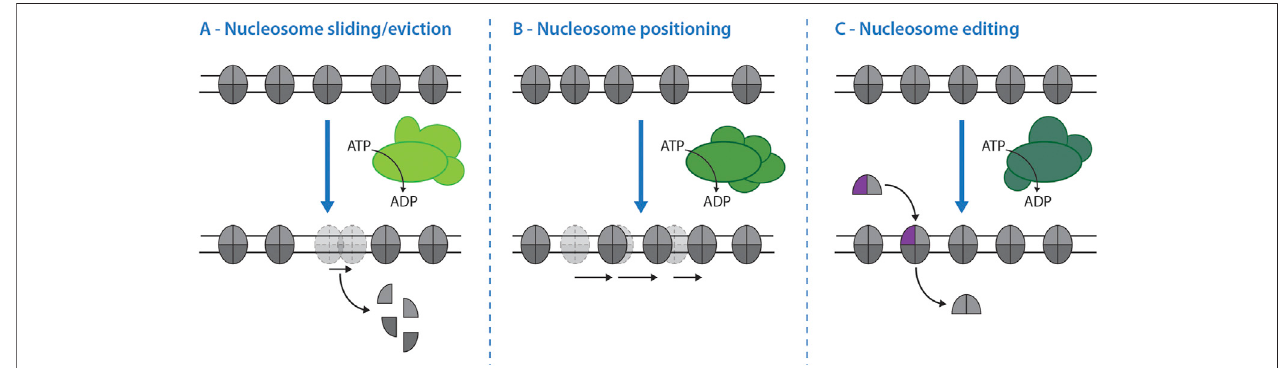
FIGURE 2 | Nucleosome remodeler activities and their effects on chromatin. The activity of different nucleosome remodelers (shades of green) can result in three principal effects on nucleosomes. (A) – Nucleosome sliding and eviction. While all remodelers have the propensity to slide nucleosomes, eviction of nucleosomes from double-stranded DNA iscatalyzed mainly by theSWI/SNFsub-family ofnucleosomeremodelers. (B) – Nucleosome positioning. Some nucleosome remodelers have the abilitytoslideandpositionnuclesomesonDNAinacontrolledfashionthatleadstotheformationofregularlyspacedarrays.Inthebuddingyeastsystemthisactivity is catalyzed mainly by ISW1a-, ISW1b-, Chd1 and INO80-complexes. (C) – Nucleosome editing. Nucleosome editing is de fi ned as the exchange of canonical histones (grey) for non-canonical histone variants, like H2A.Z (purple), within the nucleosome and vice versa. In budding yeast H2A/H2A.Z exchange is performed by the INO80 sub-family of remodelers: the SWR1-complex catalyzes the incorporation of H2A.Z-H2B dimers, while the INO80-C is thought to catalyze the reverse reaction.